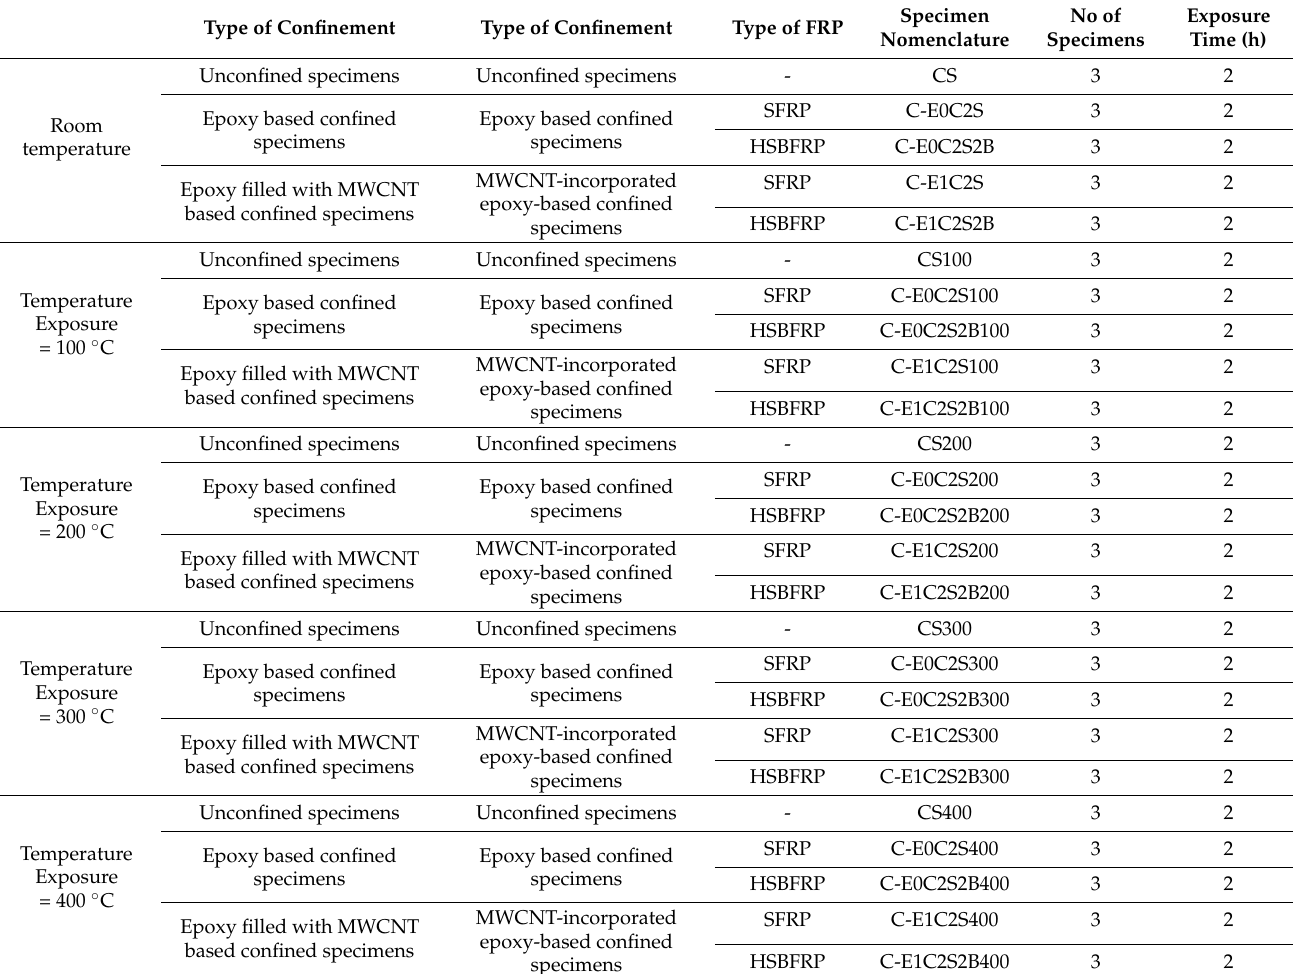
Table 2. Summary of test specimens and temperature